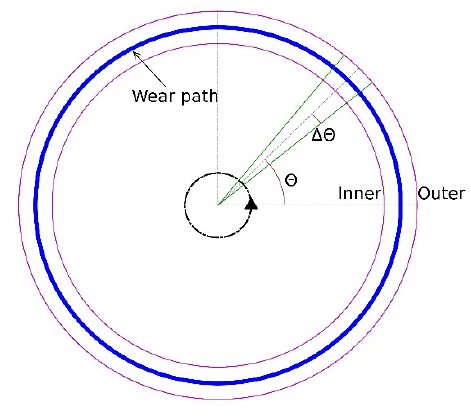
Figure 6. Illustration of data extraction.